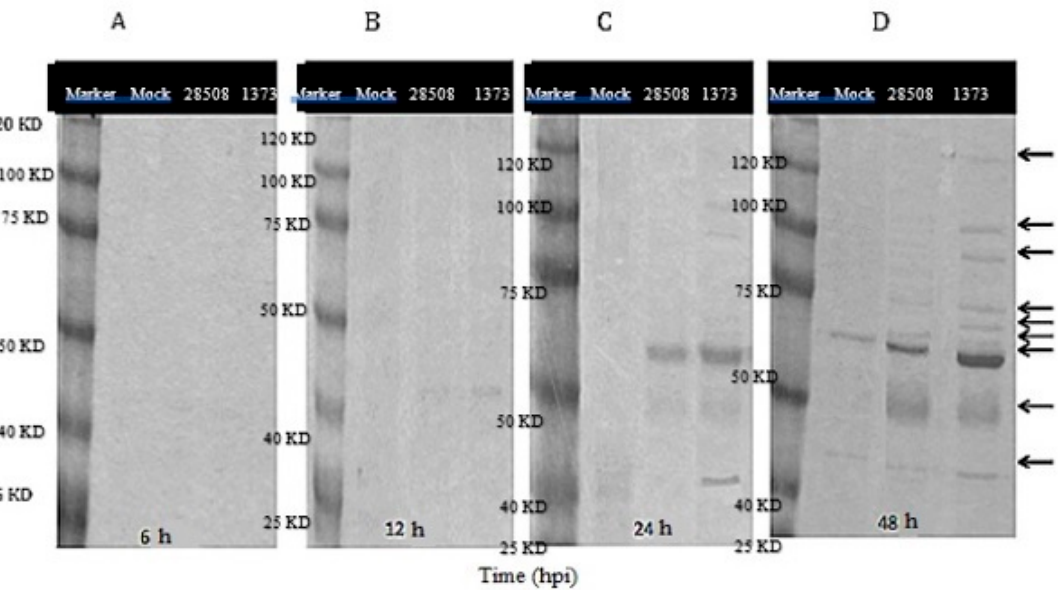
Figure 9. Protein electrophoresis of supernatants from BVDV infected and mock-infected MDM at ( A ) 6 hpi, ( B ) 12 hpi, ( C ) 24 hpi and ( D ) 48 hpi. Marker: protein marker that range from 25 to 120 KD, Mock: non-infected macrophage control, 28508: supernatant from 28508-5-infected macrophage at different timepoints, 1373: supernatant from 1373-infected macrophage at different timepoints, 6, 12, 24, 48 hpi: the corresponding timepoints post treatment of macrophage with supernatant, arrows refer to the different band intensity between strains.